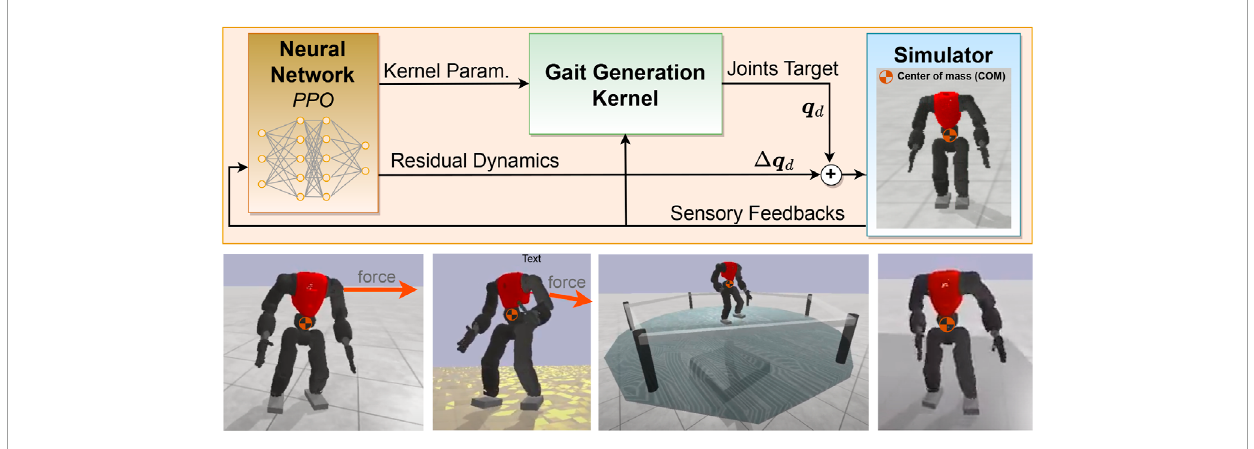
FIGURE 1 Overview of the proposed framework along with a set of snapshots of tests on different terrains: the gait generation kernel produces closed-loop locomotion, the neural network regulates the kernel’s parameters and generates compensatory